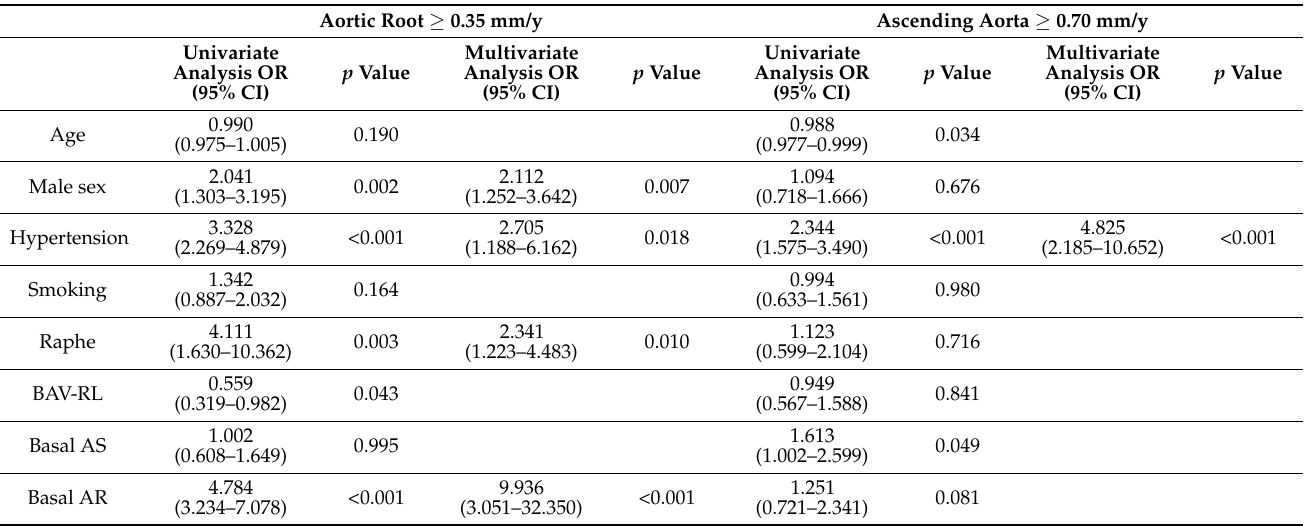
Table 3. Predictors of fast progressive aorta dilation.